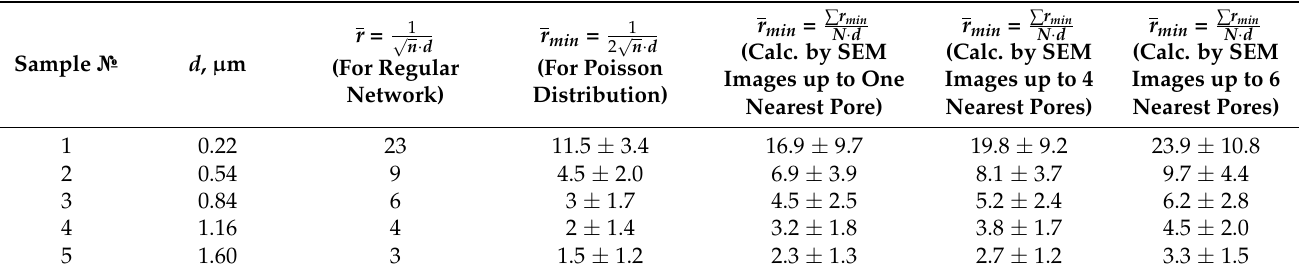
Table 4. Relative (expressed in diameters) mean distances between pore centers for TMs with n = 4·10 6 cm − 2 and different diameters.